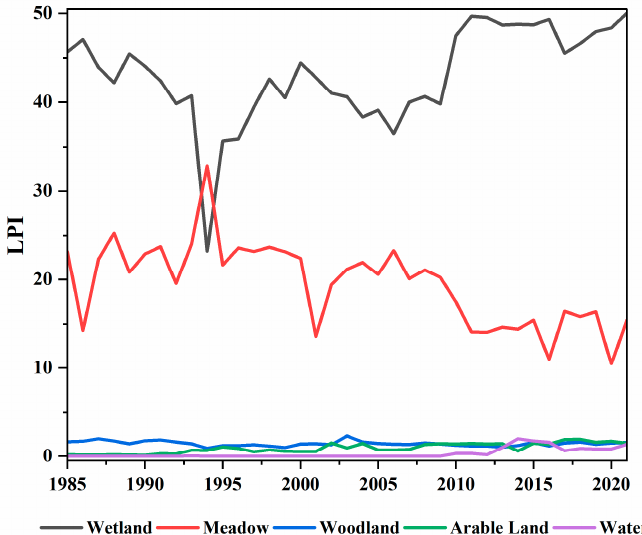
Figure 6. Change in LPI values of the landscape types in the HNNR from 1985 to 2021.